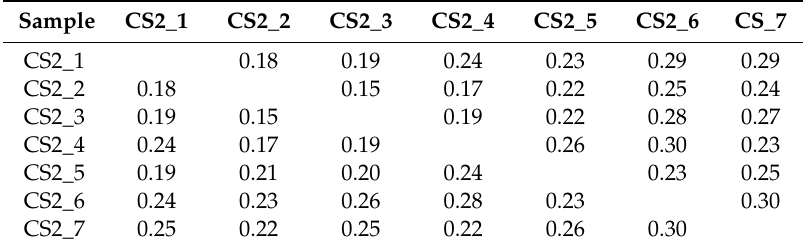
Table 6. KS-D values of sample comparisons of case study 2 using the standard KS-D approach, sample in question in first line.